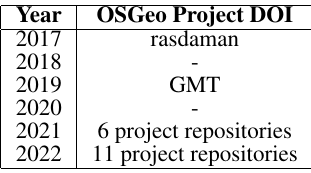
Table 2. Annual rate of of OSGeo project repositories registering DOI from 2017 to June